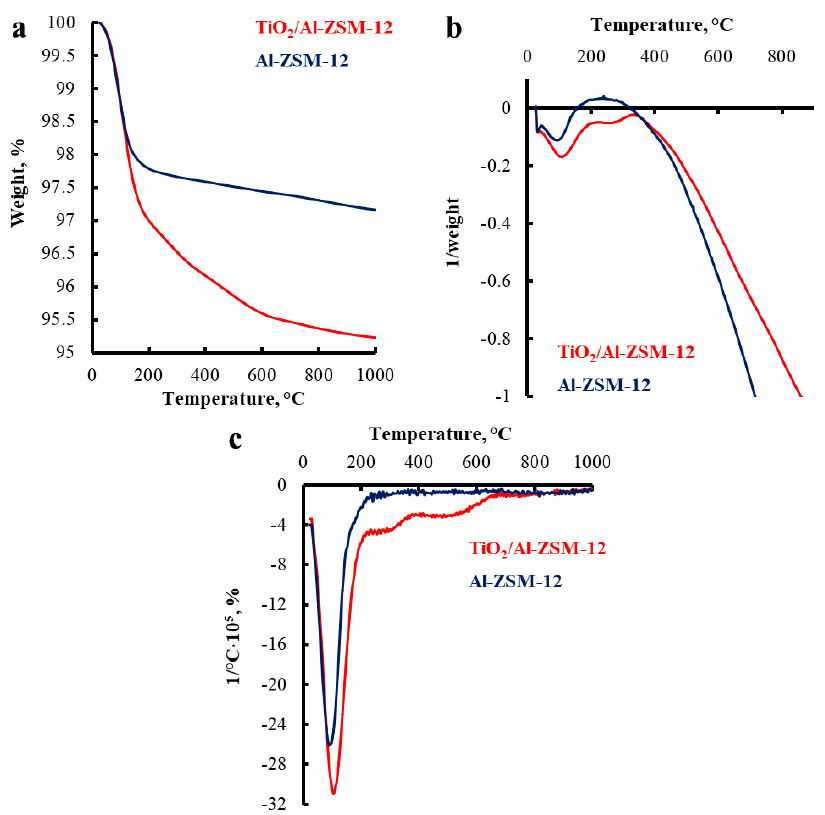
Figure 6. ( a ) TG, ( b ) DSC, and ( c ) DTA of synthesized zeolites.